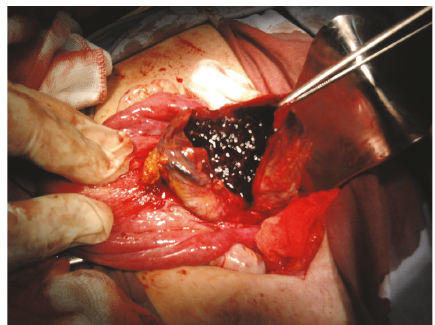
Figure 5: Operative view of the opening of the sac containing placenta increta and blood clots.